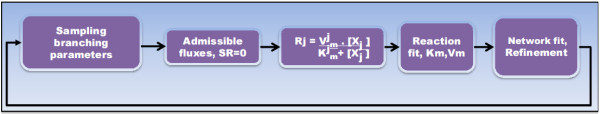
Flowchart illustrating the hybrid optimisation method used for modeling. Branching parameters are discretized and sampled to calculate admissible fluxes. For each individual reaction, Michaelis-Menten formula is inverted to obtain the parameters Km,Vmax. A final optimisation step leads to refined parameters for the full network.